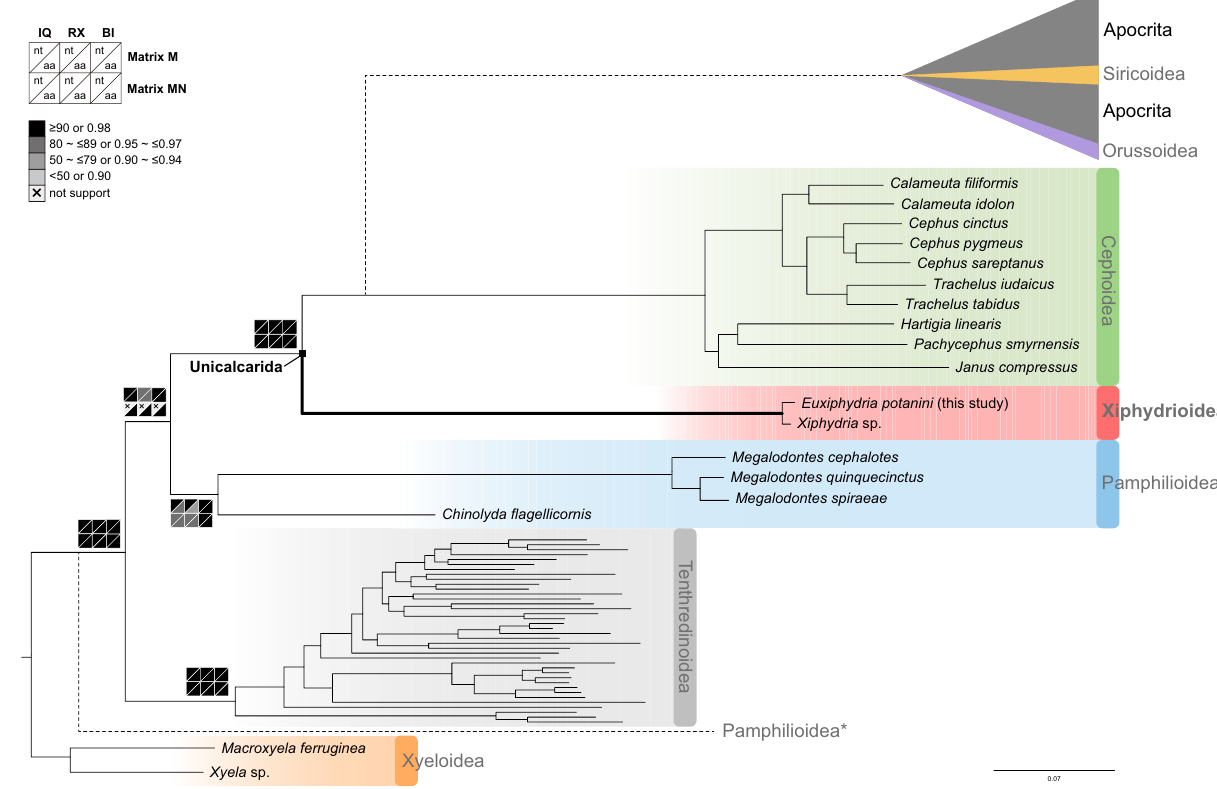
Figure 3. ML tree showing the phylogenetic position of Xiphydrioidea within Symphyta based on the mitochondrial nucleotide sequence alignment set (Matrix Mnt). The tree was constructed using IQ-TREE web server 37 , and it is shown as a representative for twelve phylogenetic trees, including four IQ-TREE (IQ)-based ML, four RAxML (RX)-based ML, and four MrBayes-based BI trees inferred from Matrices Mnt, MNnt, Maa, and MNaa (Figs. S6–17). Node confidence values resulting from the twelve trees are plotted on the respective branches by black, dark gray, gray, and light gray boxes along with ranges of bootstrapping values or posterior probability as specified in the upper left corner. The IQ-based ML, RX-based ML, and BI trees produced based on MNnt showed that the monophyletic Pamphilioidea (asterisk) is placed as sister to all other hymenoterans except for Xyeloidea, whereas all other analyses supported that Pamphilioidea is a sister group of Unicalcarida in common. The group comprising Apocrita, Orussoidea, and Siricoidea is shown as a sister to Cephoidea, according to the topology shown in Fig.